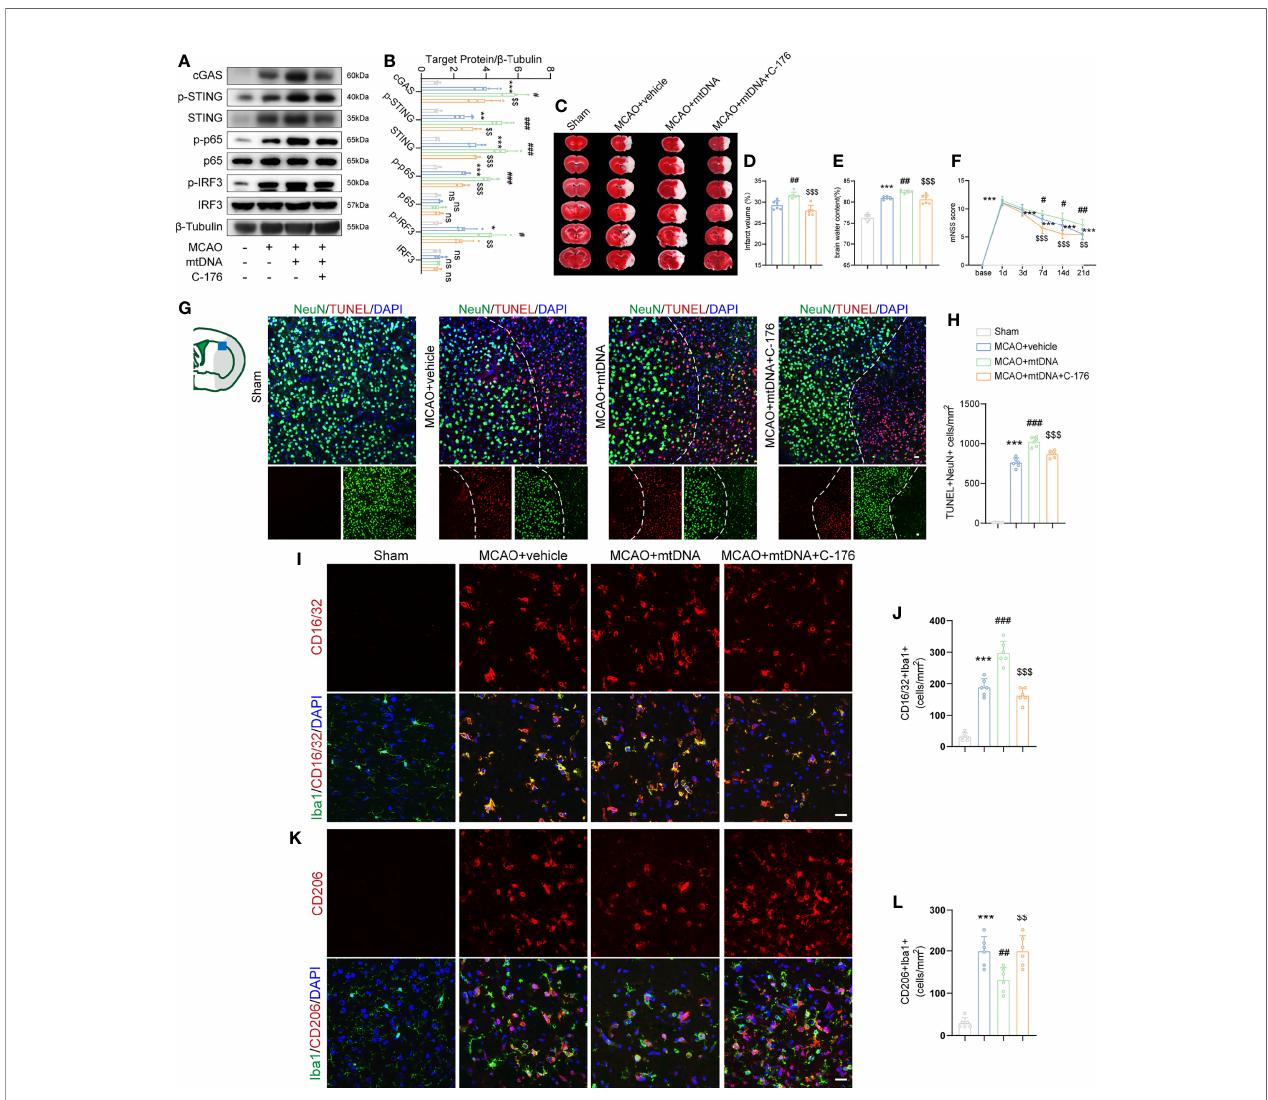
FIGURE 7 | mtDNA induced microglial M1 polarization by activating STING signaling pathway. (A, B) Western blot and quanti fi cation analysis of cGAS, p-STING, STING, p-p65, p65, p-IRF3 and IRF3 in Sham-, MCAO+vehicle-, MCAO+mtDNA-, and MCAO+mtDNA+C-176-treated mice 1d after reperfusion. n = 4. (C-E) Representative TTC staining images and quanti fi cation of infarction volume and brain edema 1d post-MCAO. n = 6. (F) mNSS score was assessed at day 1, 3, 7, 14 and 21 after MCAO. MCAO 1-7 d: n = 10; MCAO 14-21 d: n = 8. (G, H) TUNEL (red) and NeuN (green) double immunostaining with quantitative analysis. Dotted line designates the infarct borderline. n = 6. (I – L) Representative confocal images and quanti fi cation of M1 modality microglia (CD16/32 + /Iba1 + ) and M2 modality microglia (CD206 + /Iba1 + ) in the indicated groups. n = 6. Scale bar = 20 m m. Data are expressed as mean ± SD. * P < 0.05, ** P < 0.01, *** P < 0.001 vs Sham group; # P < 0.05, ## P < 0.01, ### P < 0.001 vs MCAO+vehicle group; $$ P < 0.01, $$$ P < 0.001 vs MCAO+mtDNA group. n. s., no signi fi cant